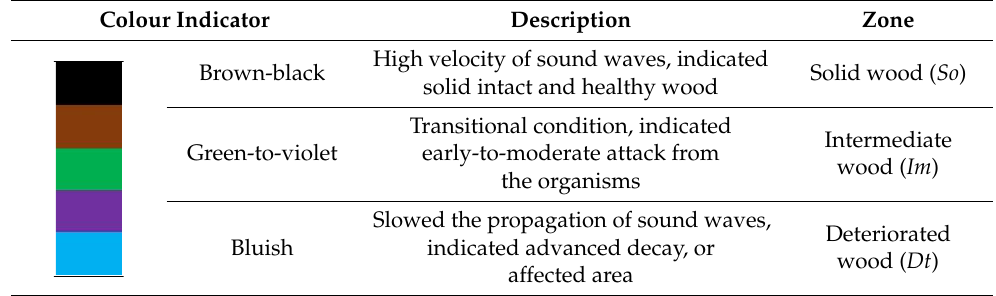
Table 3. Colour Legend Showing the Internal Condition of the Wood (by PiCUS ® Software).